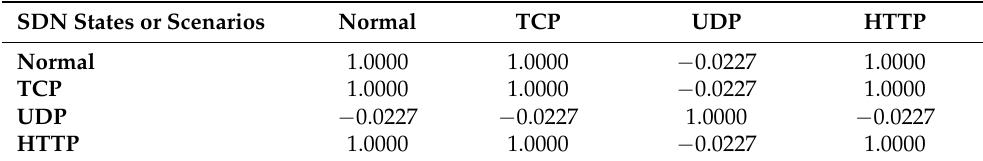
Table 9. Correlation matrix for J t when the SDN is operating normally and subjected to popular variants of DDoS flooding attacks.